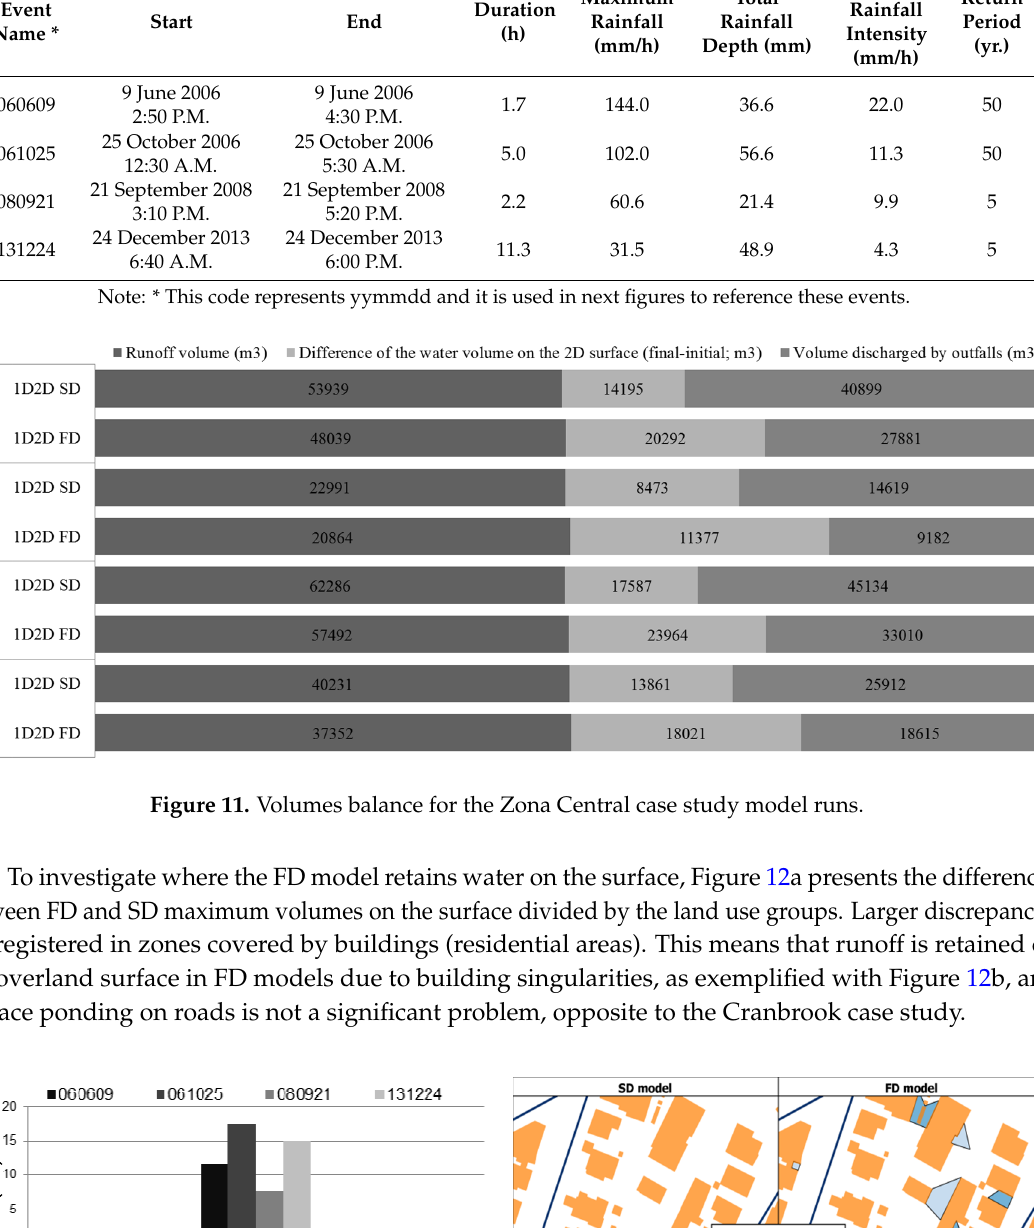
Table 2. Summary of rainfall records in Zona Central case study.